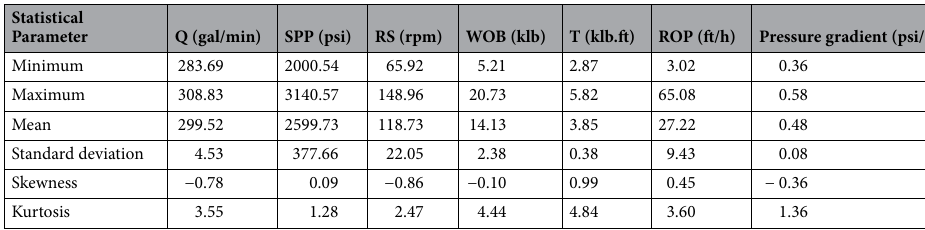
Statistical Parameter